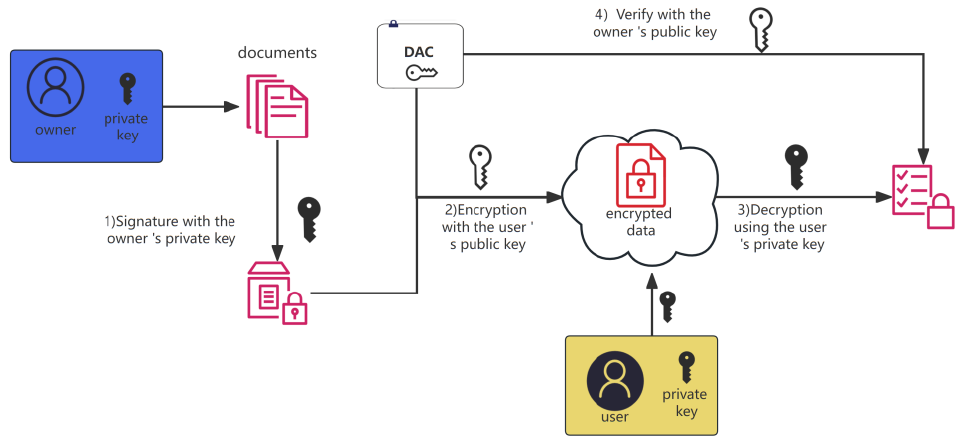
Figure 5. Double Figure 5. Double encryption.